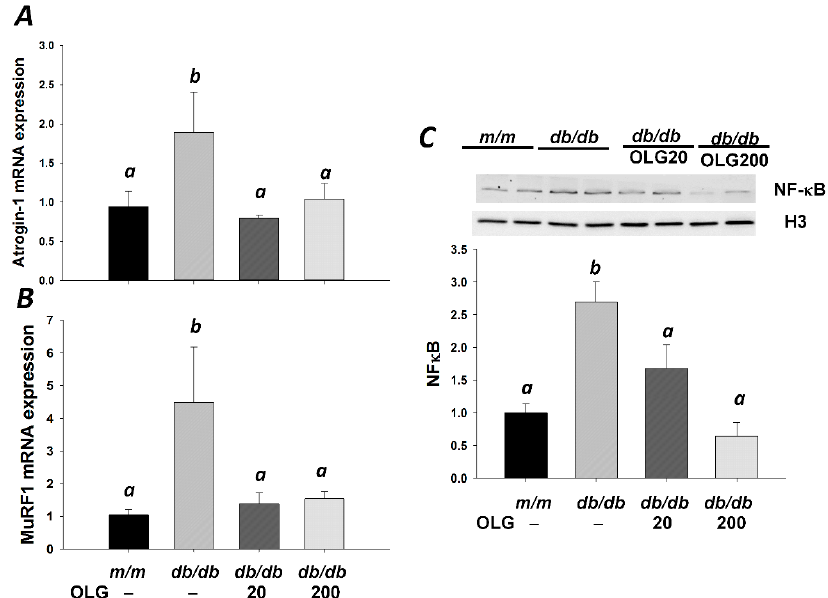
Figure 1. The cross-sectional area of tibialis anterior muscle in m/m , db/db mice, and db/db mice with oligonol (OLG) supplementation. ( Aa – d ) Myofibers were stained with hematoxylin-eosin (400×); ( B ) Mean cross-sectional area of tibialis anterior muscle; ( C ) The distribution of myofiber sizes in tibialis anterior muscles from m/m and db/db mice; and ( D ) db/db mice with or without oligonol (OLG) supplement.